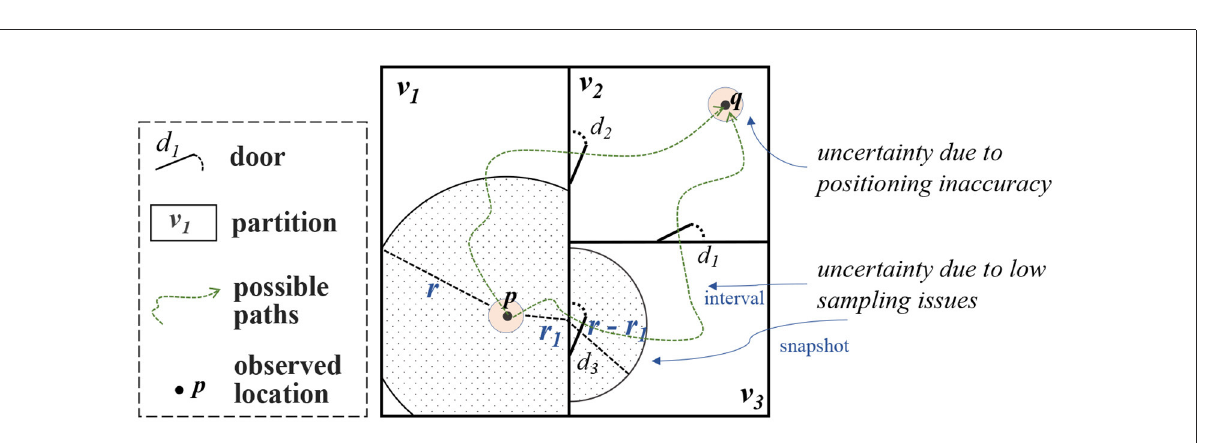
FIGURE4 An example of different kinds of spatial data uncertainties in